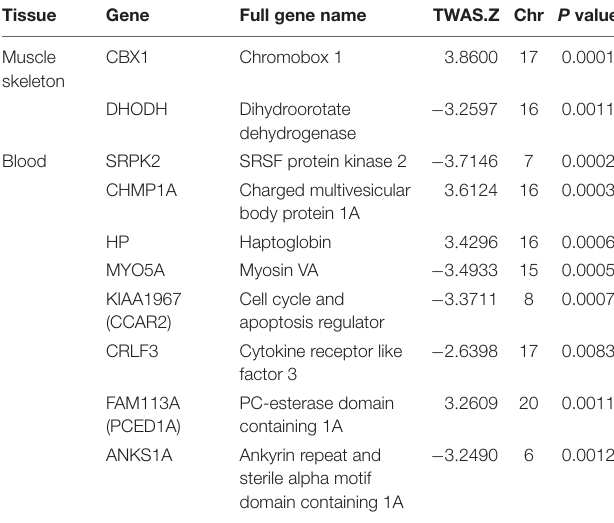
Table 1 . We also identified 128 genes with P values < 0.05